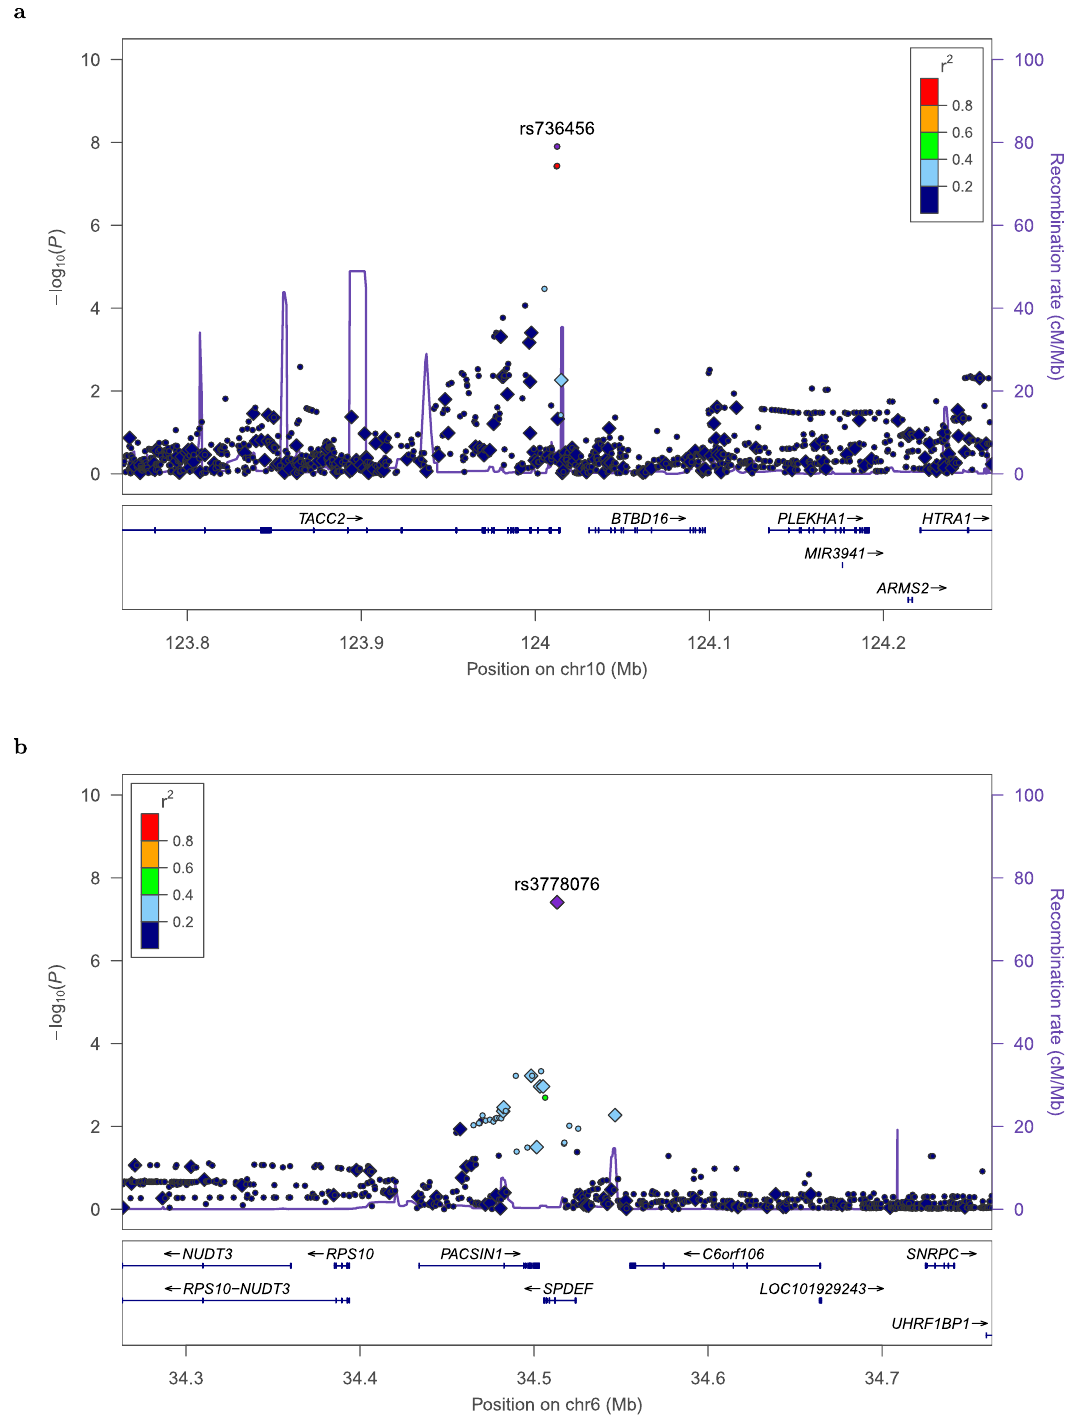
Fig. 2 Regional association and linkage disequilibrium plots for loci associated with progressive CLL. Regional plots of time to fi rst time treatment (TTFT) survival associations for rs736456 ( a ) and rs3778076 ( b ) reaching genome-wide signi fi cance ( P ≤ 5 × 10 − 8 ). Study-speci fi c single nucleotide polymorphism (SNP) effects were combined in a fi xed effect model using an inverse-variance-weighted method. Nominal meta-analysis P values were calculated based on Z -score statistics and all statistical tests were two-sided. Plots show SNP coordinates based on genomic build b37/hg19 on the x -axis, and − log 10 ( P values) on the y -axis. Genotyped and imputed SNPs are represented by diamonds and circles, respectively, and are colored according to their linkage disequilibrium (pairwise r 2 ) with the lead SNP based on the 1000 Genomes European panel. Reference genes in the region are shown in the lower panel, with arrows indicating transcript direction, dense blocks representing exons and horizontal lines representing introns. Two additional SNPs at 10q26.13 (rs4752676 and rs736457) ( a ) and one additional SNP at 6p (rs11757517) ( b ) also reach genome-wide signi fi cance in meta-analysis (Supplementary Figs. 60 – 62). The symbol for rs11757517 is obscured on the regional plot ( b ) by the symbol for